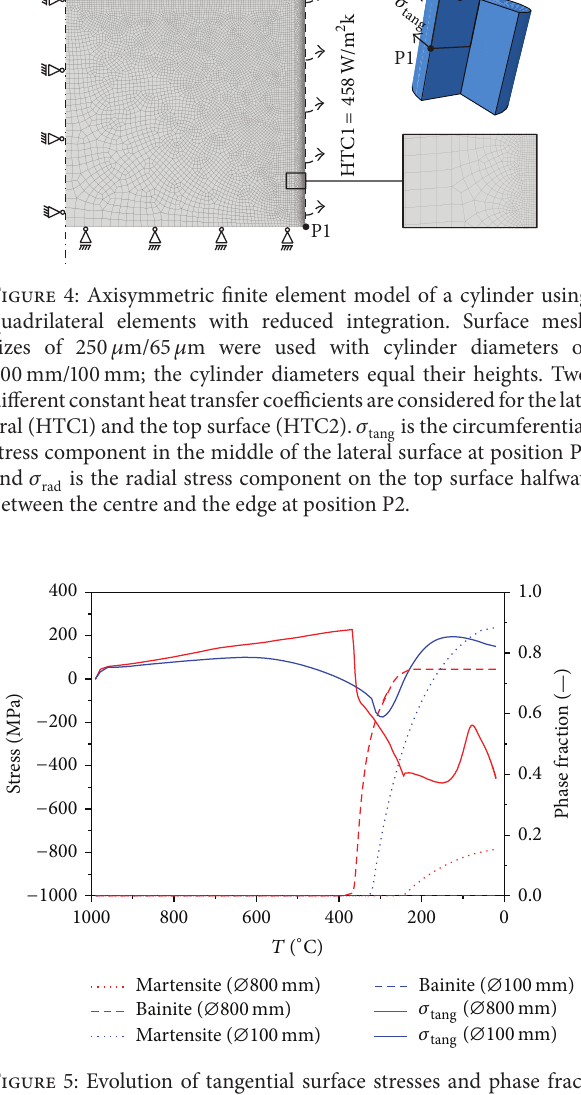
Figure 5: Evolution of tangential surface stresses and phase frac- tions at position P1 on two cylinders of different sizes (Ø800 mm, Ø100mm). The small cylinder is quenched from 990 ∘ C with gaseous nitrogen at a pressure of 6 bar and the same thermal boundary conditions are applied to the large